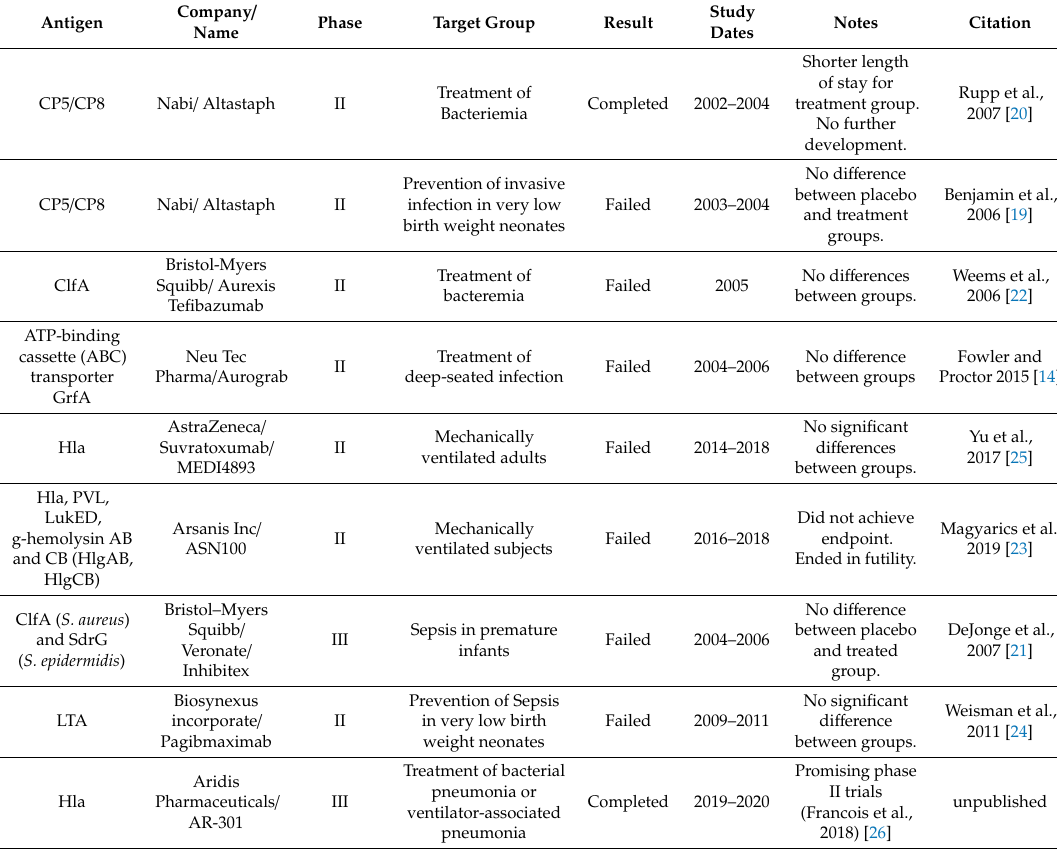
Table 1. Clinical trials of passive S. aureus